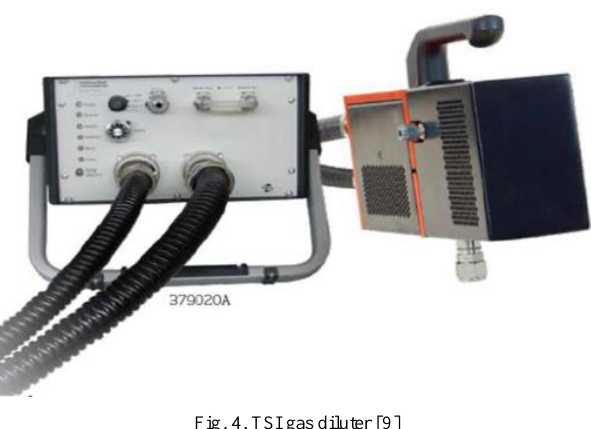
Fig. 4. TSI gas diluter [9]